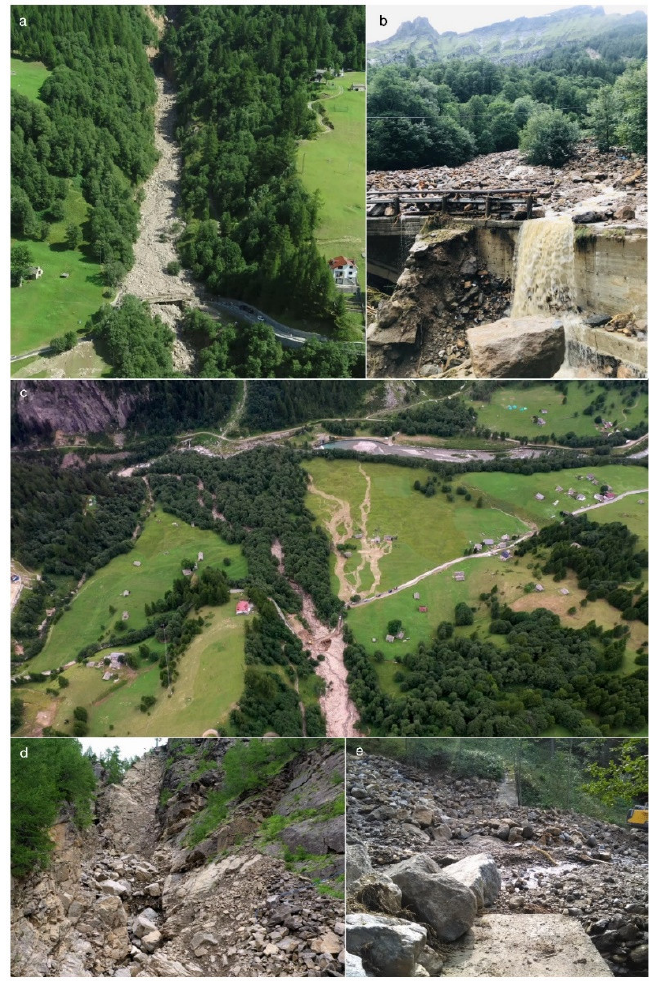
Figure 7. The 12 August 2019 debris flows event along the Croso stream—( a ) The bridge covered and filled in below by debris flow accumulation (view taken from the drone video, see along the text); ( b ) a particular of the left-hydrographic side deviation of the Croso stream active channel (see Figure 6c); ( c ) view of the earth flows starting down-stream respect to the bridge (view taken from the drone video, see along the text); ( d ) the up-stream conditions of the Croso stream bed with abundant disrupted deposits (view taken from the drone video, see along the text) (see Figure 6d); ( e ) a check dam, upstream to the bridge, overwhelmed by debris (see Figure 6c).